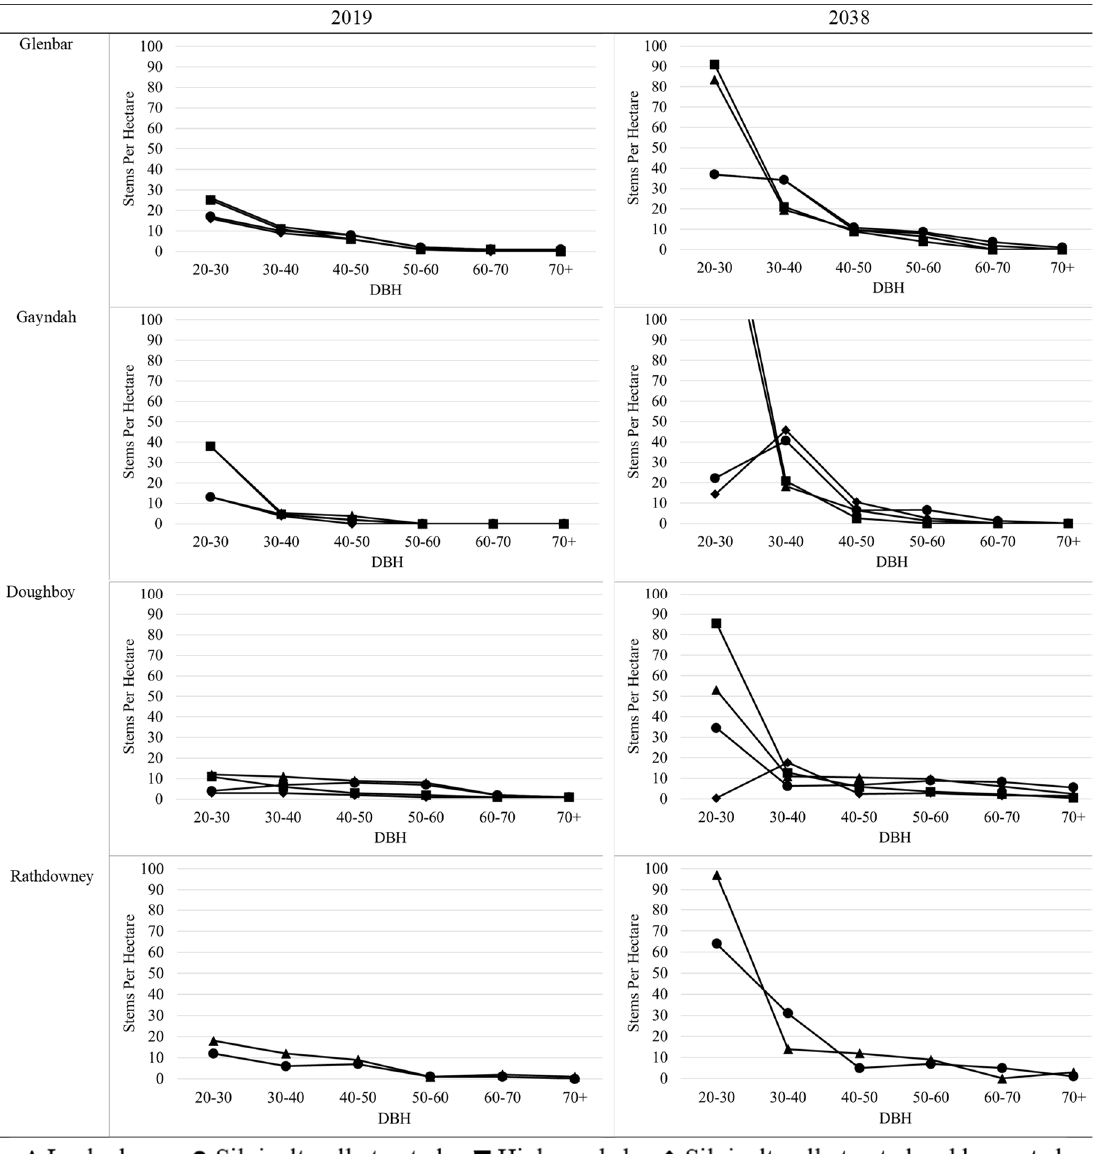
Figure 3. Stocking following treatment in year zero ( left ) and before harvest in year 20 ( right ). DBH (cm) is presented in a range of categories. Note: Where lines are not visible for all four scenarios, the scenarios overlap each other and follow a similar diameter distribution in SPH. In 2038, the silvicul- tural treatment (only), and harvest and silvicultural treatment scenarios follow a similar diameter distribution and the locked-up and high-graded scenarios follow a similar diameter distribution at both Glenbar and Gayndah. For the Rathdowney site, only the locked-up, silviculturally treated and clear for grazing scenarios were assessed as no stems were available for harvest in the inventory.